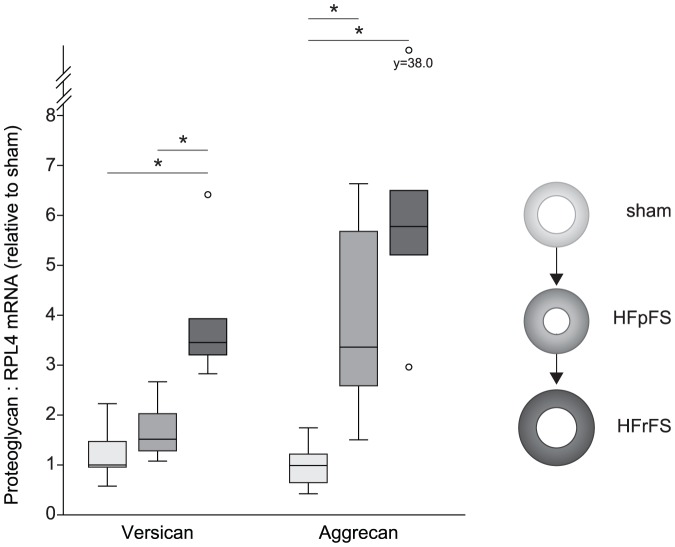
Elevated mRNA levels of versican and aggrecan in rats after aortic banding.Myocardial mRNA expression of versican and aggrecan in rats with preserved (HFpFS, n = 9) or reduced FS (HFrFS, n = 6) six weeks after AB, normalized to the reference gene RPL4 and relative to sham (n = 9). Box-plots show median (horizontal line), interquartile range (box), 1.5xinterquartile range or maximum/minimum range (whiskers) and outliers (>1.5xinterquartile range). *p<0.05. AB, aortic banding; FS, fractional shortening; ribosomal protein L4, RPL4.